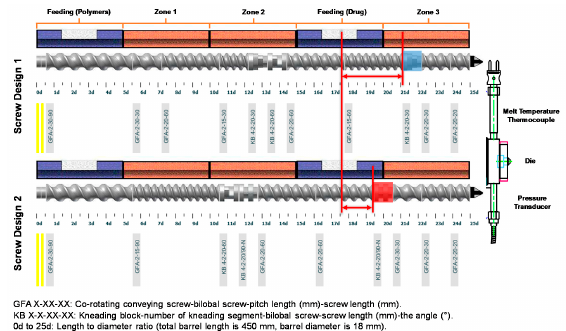
Figure 4. Barrel configurations and screw designs. Screw design 1: 30° and 60° kneading elements in zone 2, and one 30° kneading element (blue) in zone 3; screw design 2: 60° and 90° kneading elements in zone 2, and one 90° kneading element (red) in zone 3. As shown in Table 1, CBZ dihydrate and form-III CBZ anhydrate at different drug loadings were processed at various temperatures and screw speeds using two screw designs. Two drug loadings were Table 1. Summary of formulations and extrusion processing parameters used for CBZ ASDs preparation. Drug loading indicates the amount of CBZ on a dry weight achieved by changing the drug feed rate and polymer feed rate, while the total feed rate was maintained at 6 g/min. Zone 1 and zone 2 were set at 140 °C for all formulations to ensure that Soluplus ® -Vitamin E basis without hydrated water succinate blends were fully melted before feeding the drug. The temperature of the molten polymer